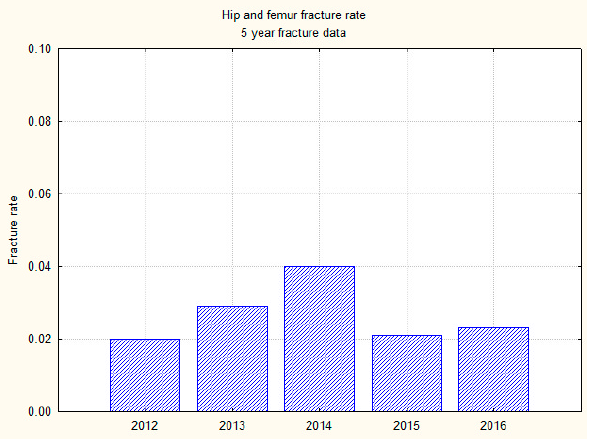
Figure 2. A bar graph showing hip fracture trend over 5 years (2012–2016).